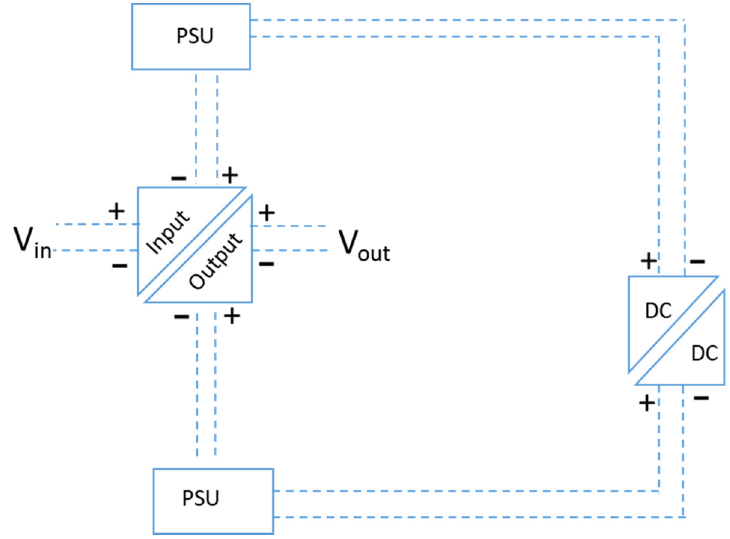
Figure 9. A block diagram of a signal conditioner.